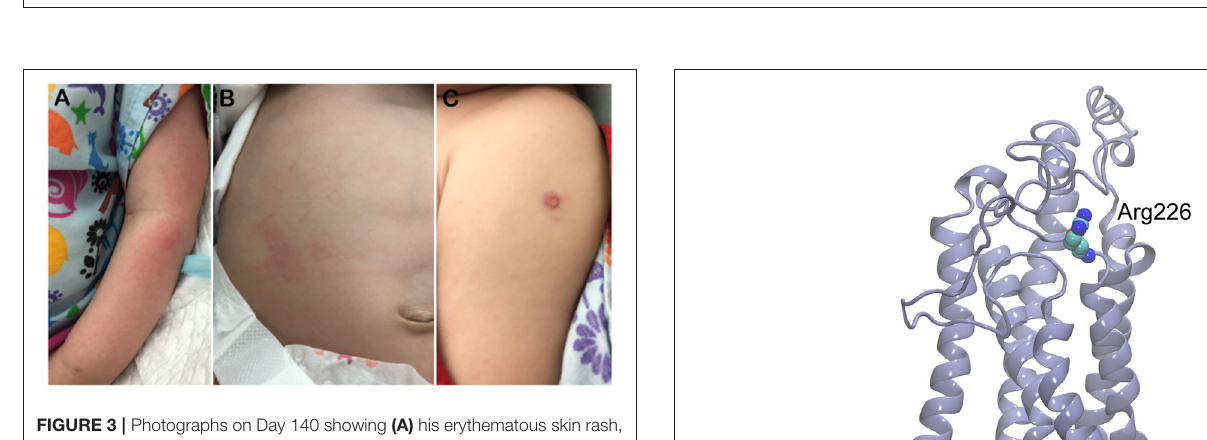
FIGURE 2 | (A) Color Doppler images on neck ultrasound scan at age of 45 days demonstrates an enlarged left cervical lymph node of increased vascularity in keeping with lymphadenitis. (B) Chest radiograph at age of 145 days shows tube and line in position, and bilateral diffuse alveolar-interstitial opacification with right pleural effusion in keeping with pulmonary edema.